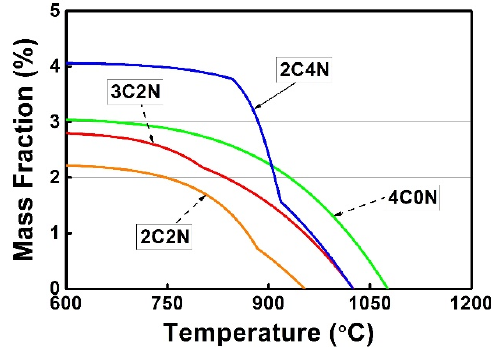
Figure 4. Mass fractions of (Cr,Fe) 23 C 6 carbide calculated by JMatPro software under the equilibrium condition and plotted as a function of temperature.